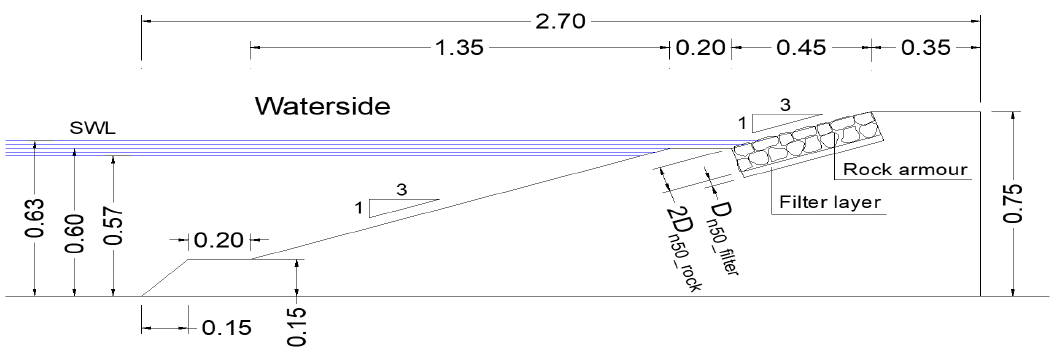
Figure 5. Test configuration (unit: m) of the R1 tests, with a rock-armoured upper slope, a smooth berm and a smooth lower slope and with D n 50_ rock = 5 cm and D n 50_ filter = 2.5